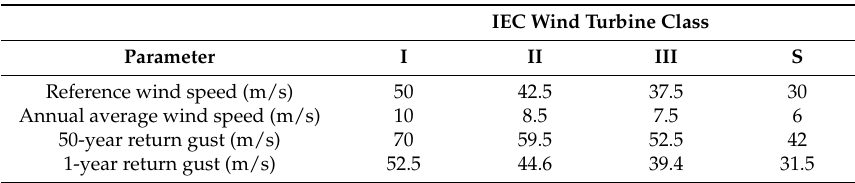
Table 5. IEC 61400-1 wind turbine classes.